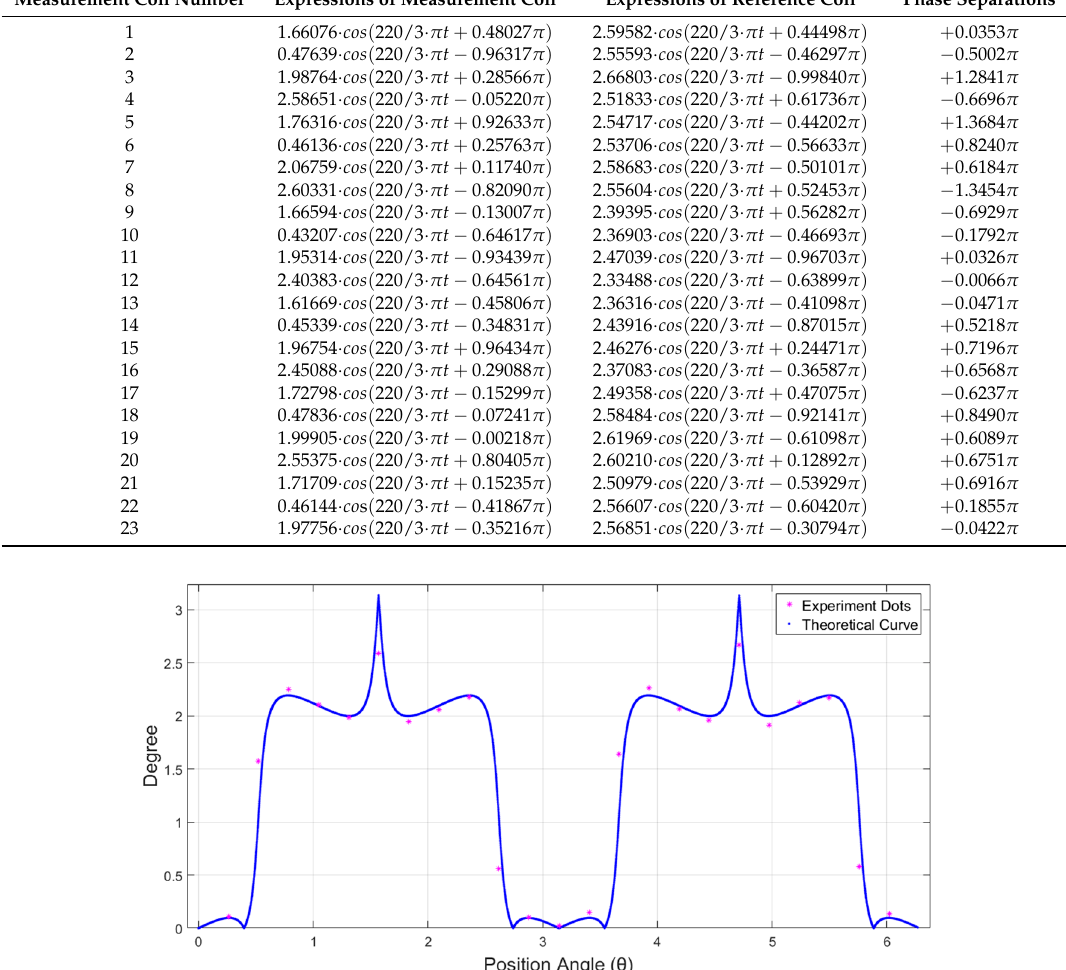
Table 2. Expressions of 23 groups of coils and corresponding phase separations.